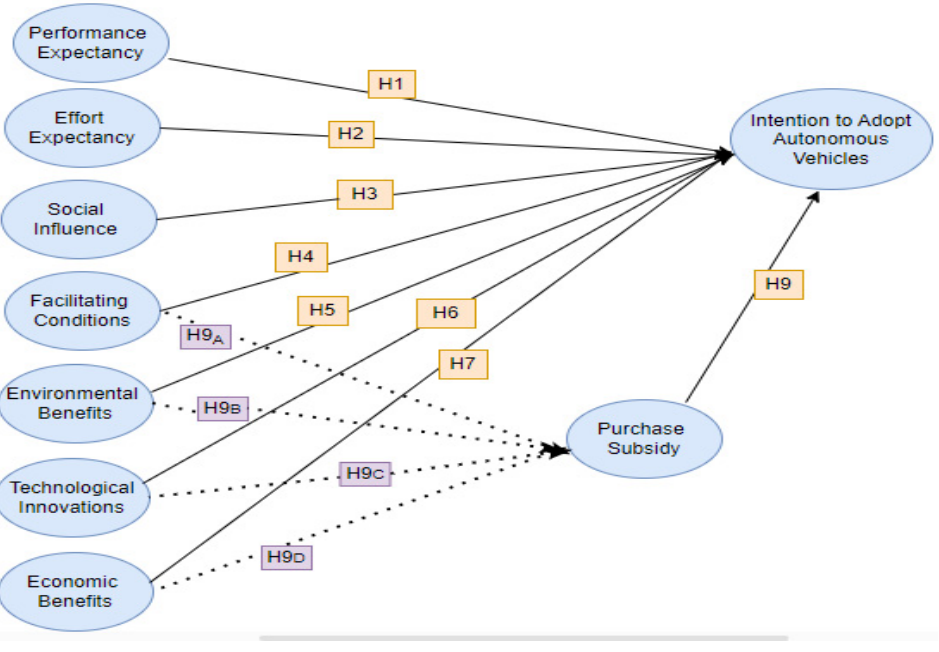
Figure 1. Conceptual framework of the study.